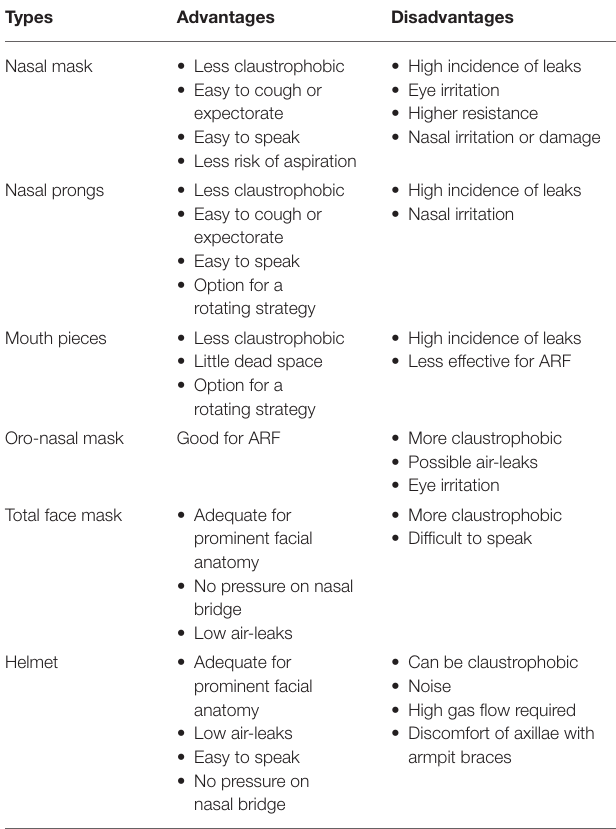
TABLE 2 | Comparison between interfaces *